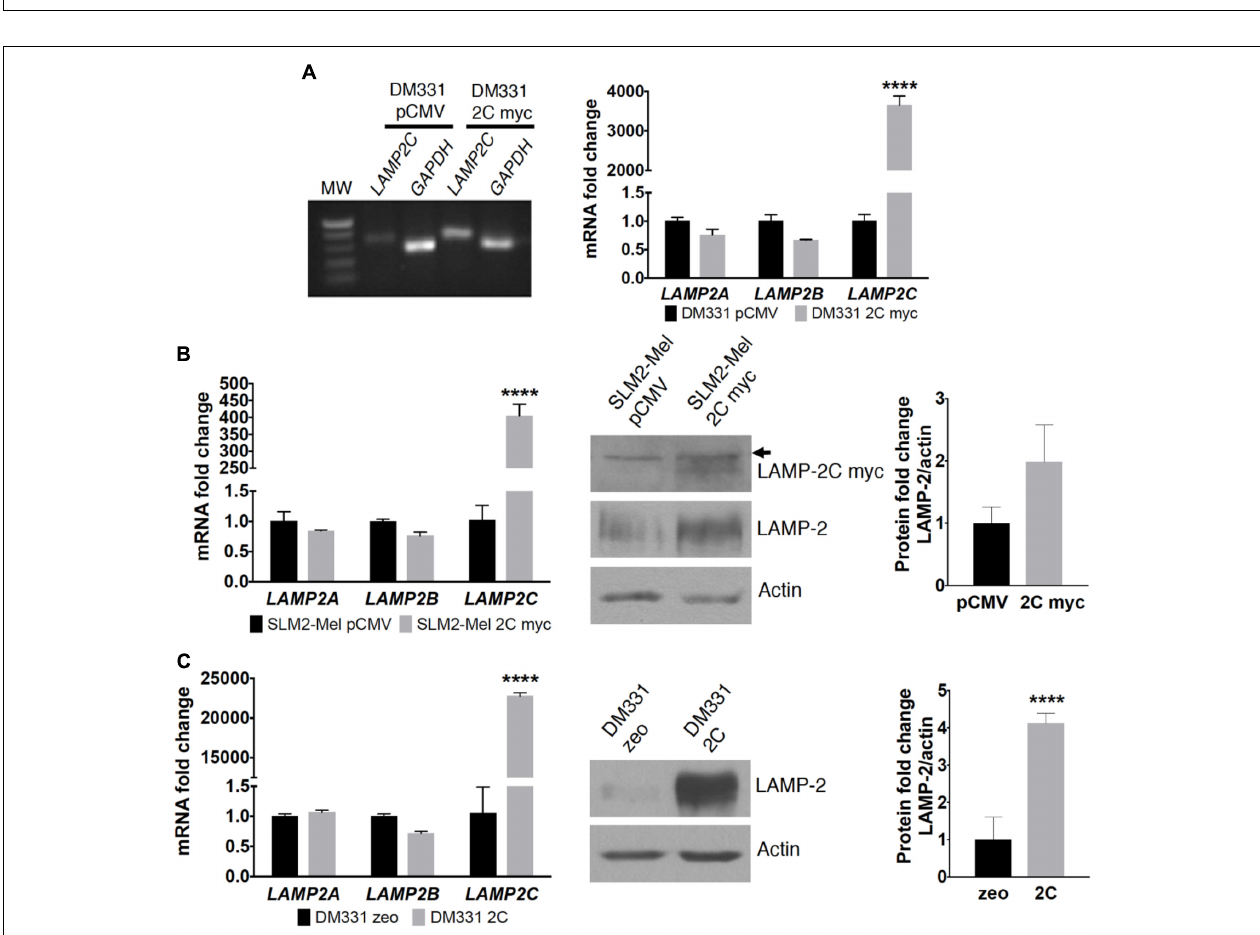
FIGURE 2 | LAMP-2 expression in human melanoma cell lines transfected with LAMP-2C. (A) DM331 cells were transfected with an empty vector (pCMV) or a plasmid encoding for C-terminal myc tagged LAMP2C . RT-PCR analysis for LAMP2C overexpression was detected in an agarose gel. mRNA levels of LAMP2A , LAMP2B , and LAMP2C transcripts were analyzed by qPCR and normalized to 18S expression. To detect relative changes in the expression of each isoform, the normalized expression of each isoform was set equal to one in DM331 pCMV cells. (B) SLM2-Mel cells were transfected with an empty vector (pCMV) or a plasmid encoding for C-terminal myc tagged LAMP2C . mRNA levels of LAMP2A , LAMP2B , and LAMP2C in these cells were analyzed by qPCR and normalized to ACTB expression. The relative expression of each isoform was set equal to one for SLM2-Mel pCMV control cells. Cell lysates were probed for the c-myc tagged LAMP2C or total LAMP2 protein with actin used as a control for sample loading. Arrow indicates non-specific protein band detected with anti-myc antibody. (C) DM331 cells were transfected with an empty vector (zeo) or a plasmid encoding for LAMP2C with no tag sequence. mRNA levels of LAMP2A , LAMP2B , and LAMP2C in these cells were analyzed by qPCR and normalized to GAPDH expression. To examine relative changes in each isoform, the expression of individual isoforms was set to one for the DM331 zeo control cells. Cell lysates were probed for total LAMP2 protein with actin used as a control for sample loading. Data were analyzed by two-way ANOVA or by two-tailed, unpaired Student’s t -test. ∗∗∗∗ p < 0.0001 ( n = 2–3).